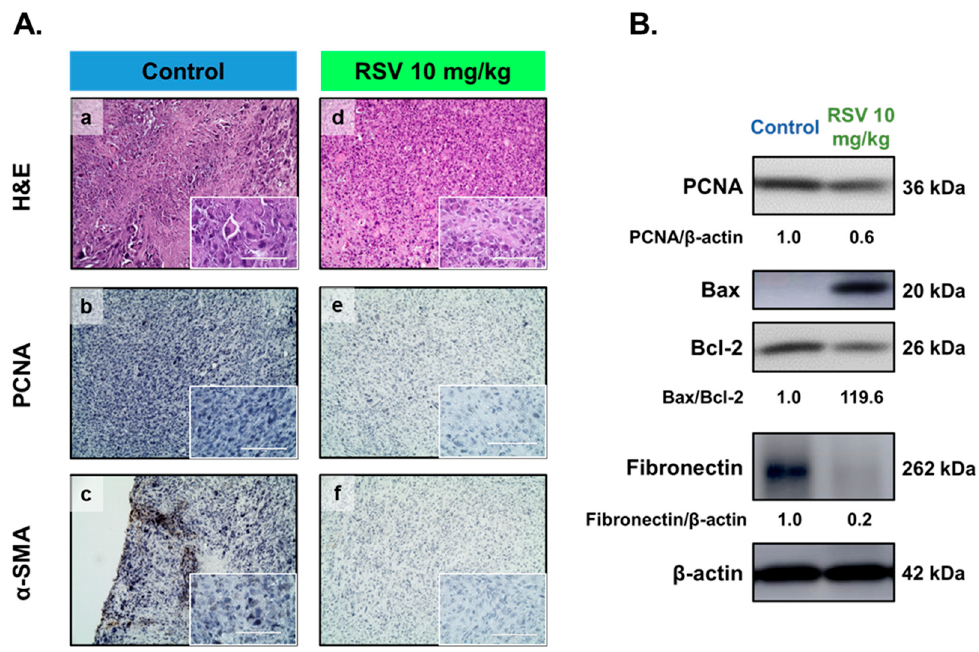
Figure 3. Effect of resveratrol (RSV) treatment on tumor xenografts. ( A ) Eker rat-derived uterine leiomyoma cells transfected with luciferase (ELT-3-LUC) tumors were excised and processed for hematoxylin and eosin (H&E) staining ( a , d ) and immunohistochemical (IHC) analysis of proliferating cell nuclear antigen (PCNA) ( b , e ) and α -smooth muscle actin ( α -SMA) (c , f ); the scale bars represent 100 μ m. ( B ) Tumor lysates were separated by sodium dodecyl sulfate polyacrylamide gel electrophoresis and analyzed on Western blotting with an anti-PCNA, fibronectin, Bax and Bcl-2 antibody. β -actin was used as a loading control. The band intensities are expressed as a ratio, relative to the loading control.